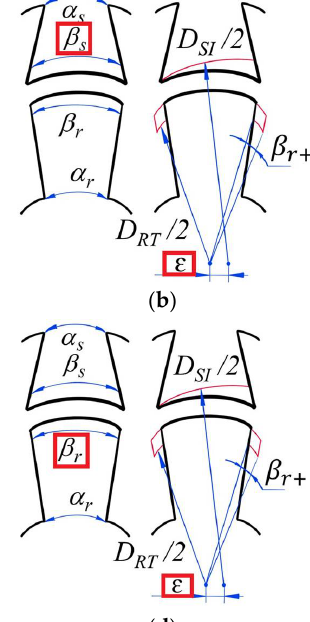
Figure 14. Peak-to-peak values of the torque ripple.